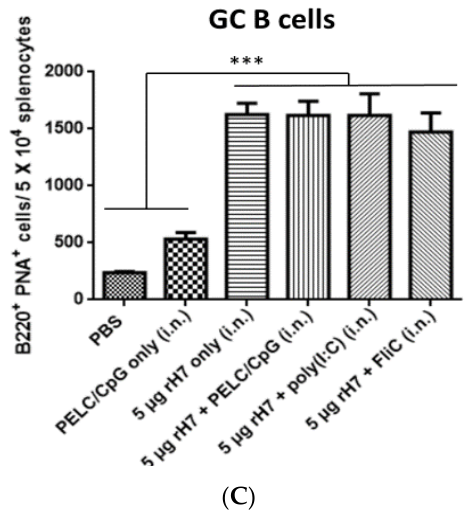
Figure 2. H7-specific IgG-, IgA-ASCs in spleen. Splenocytes isolated from immunized mice were stimulated with rH7 proteins and analyzed using ELISPOT assays to determine H7-specific ( A ) IgG-ASCs and ( B ) IgA-ASCs. ( C ) GC-B cells were determined using flow cytometry for the detection of B220 + PNA + cells. Statistical analysis consisted of one-way ANOVA. *, p < 0.05; **, p < 0.01; ***, p < 0.001.